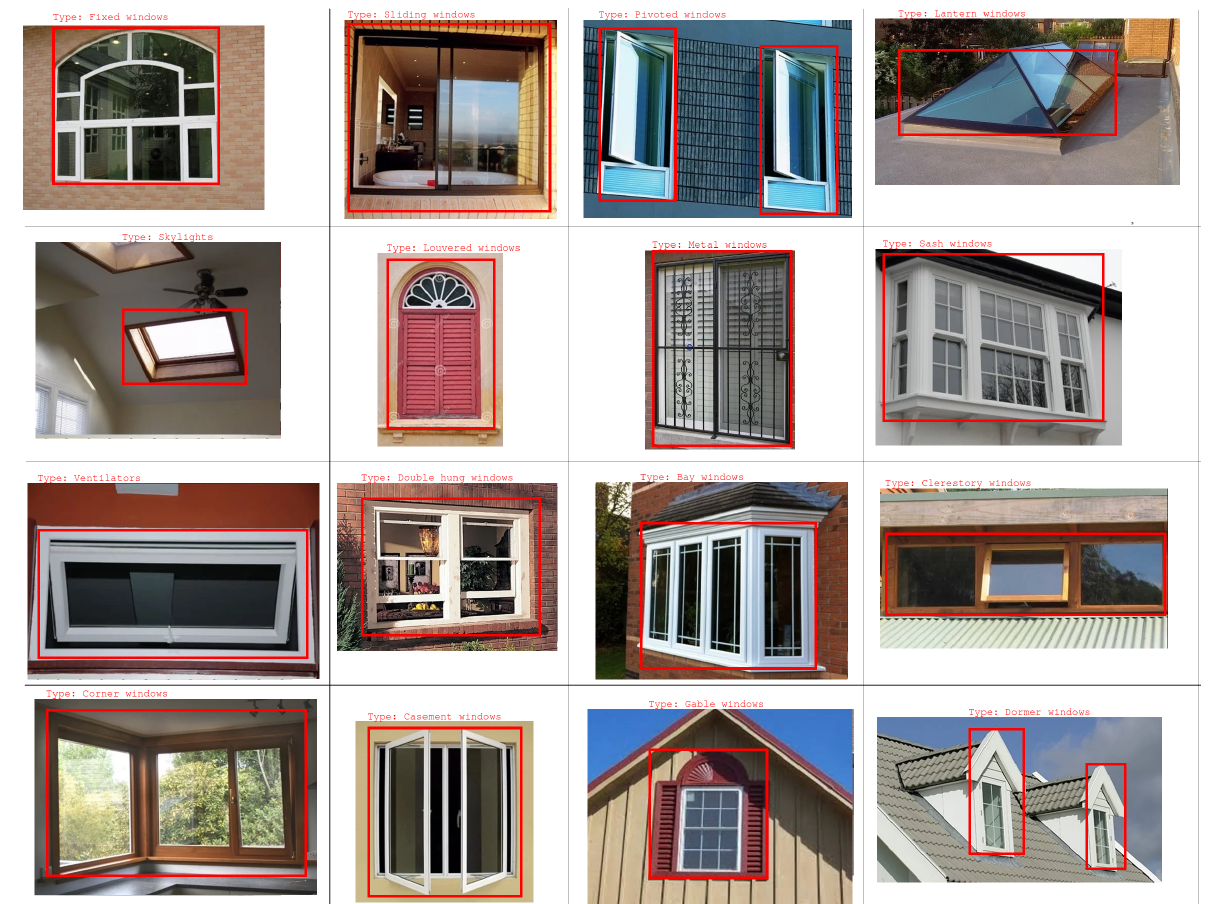
Figure 8. Window objects: sixteen types of windows, namely fixed windows, sliding windows, pivoted windows, lantern windows, skylights, louvered windows, metal windows, sash windows, ventilators, double hung windows, bay windows, clerestory windows, corner windows, casement windows, gable windows, and dormer windows are considered in the training and testing processes